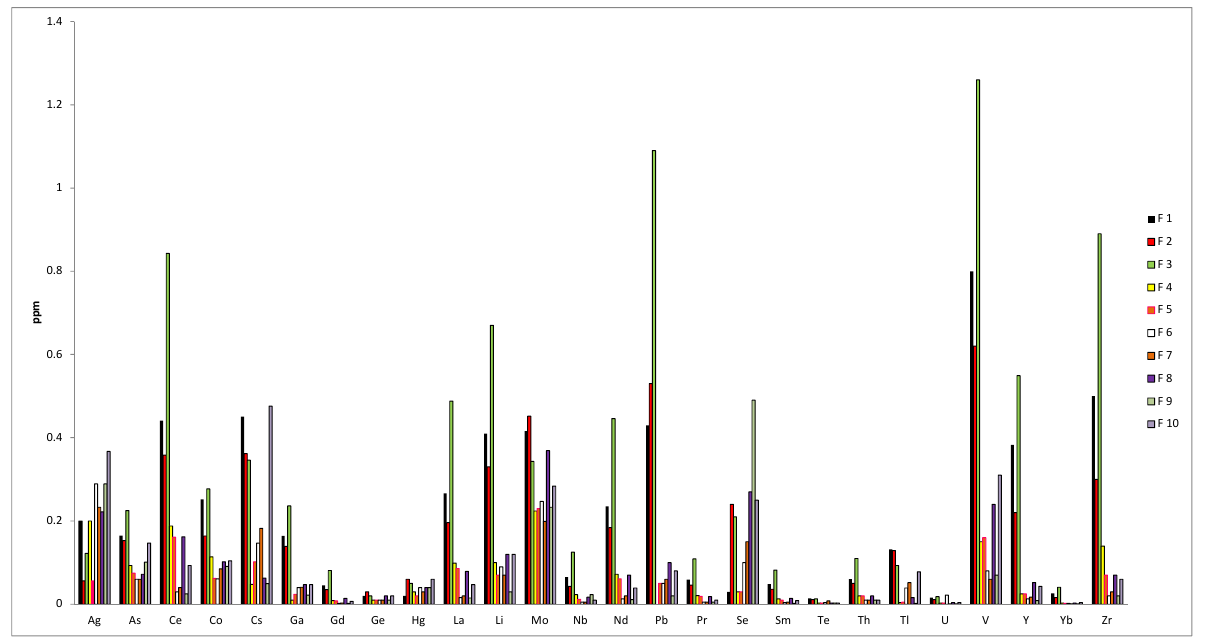
Fig. 3 Minor and trace elements in the mushroom samples (F1–F10). Elements very close or under the detection limit were not included in this